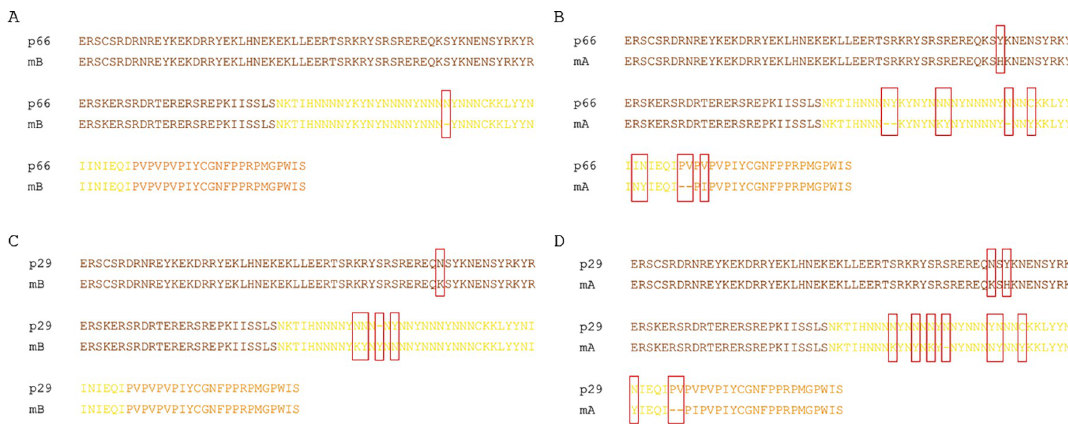
Fig 5. Alignment of amino acid sequences of csd-PSD of p66/mB, p66/mA, p29/mB and p29/mA alleles.